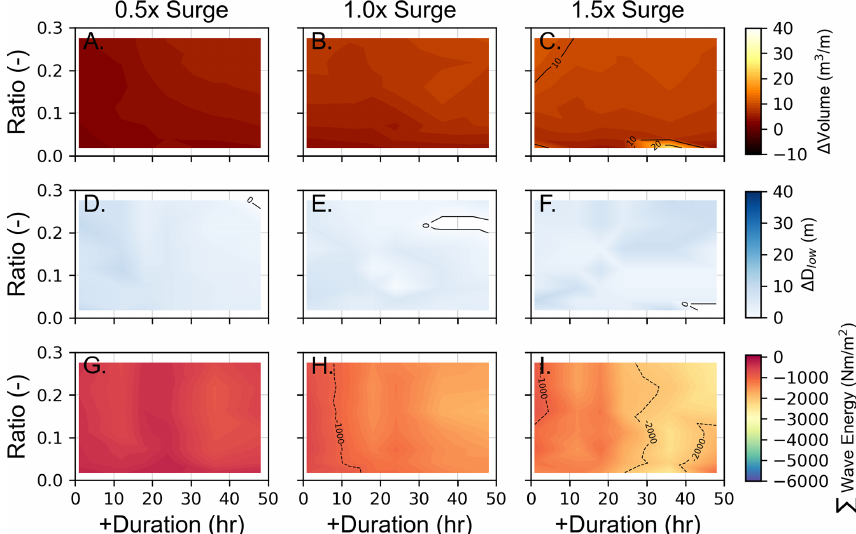
Figure 12. Relative dune erosion and wave impact energy for all fenced simulations as a function of aspect ratio versus storm duration. The values from the equivalent simulations with the dune toes have been subtracted from the fenced simulations in order to remove the influence from the presence of the fenced dune seaward of the natural dune. Each column represents a different storm surge level (increasing left to right). These values represent a comparison relative to the toe-aligned simulation (where beach width is controlled for and there is not a fenced dune) such that the top row (a–c) shows the amount of volume loss prevented by the fenced dune in these simulations, the middle row (d–f) shows the increase in dune toe progradation induced by the fenced dune, and the bottom row (g–i) shows the reduction in wave energy reaching the dune due to the fenced dune.